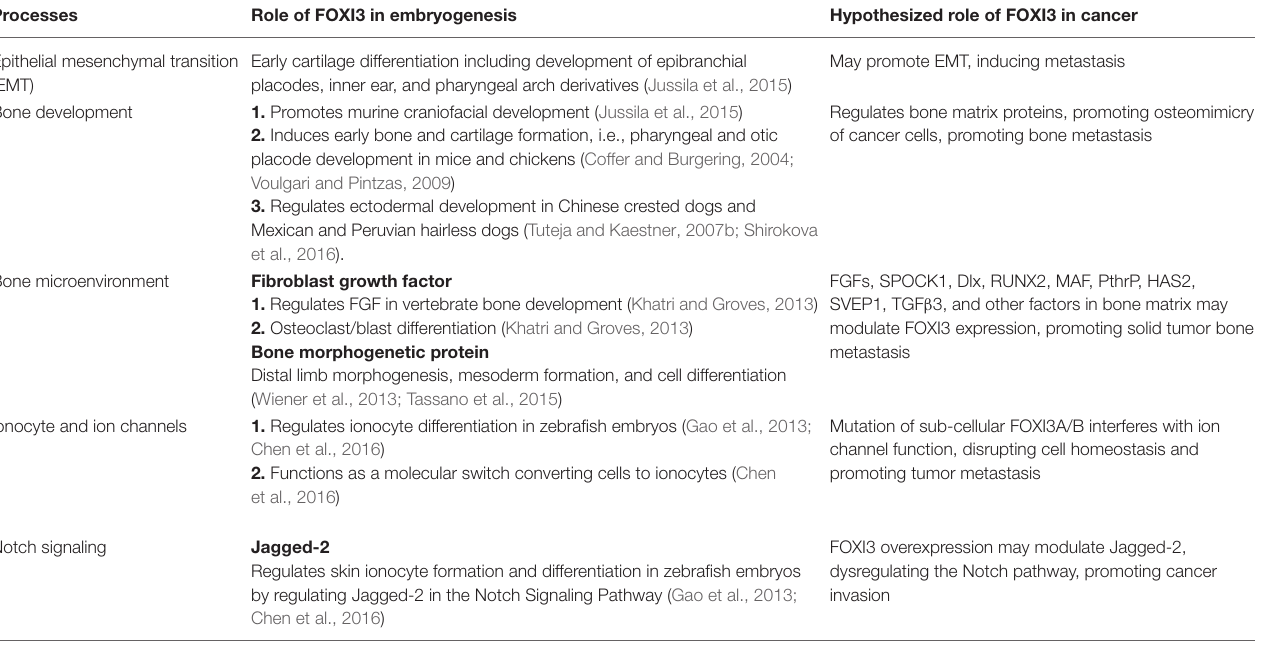
TABLE 3 | Summary describing the role of FOXI3 in development and its hypothesized role in cancer progression. Processes Role of FOXI3 in embryogenesis Hypothesized role of FOXI3 in cancer Epithelial mesenchymal transition